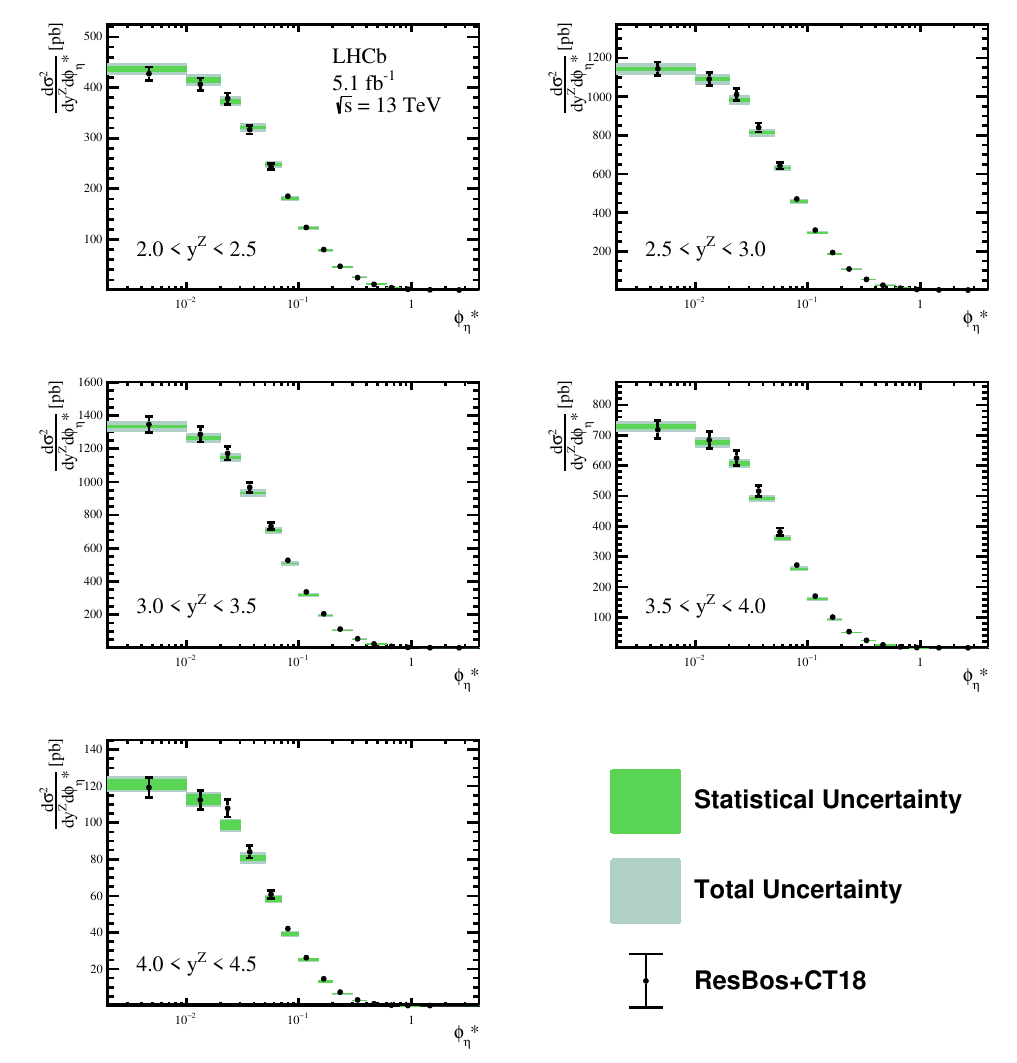
Figure 8 . Measured double differential cross-section as a function of φ ∗ with ResBos predictions, with the horizontal bars showing the uncertainty from the